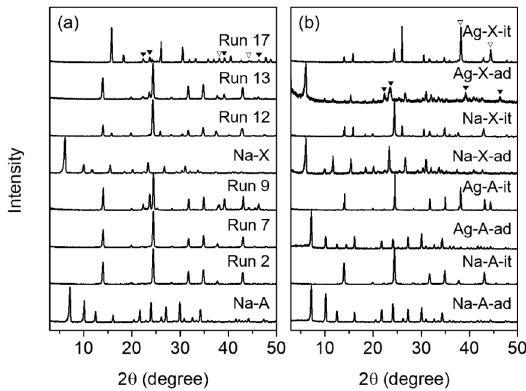
Figure 2. Powder XRD patterns of ( a ) representative products synthesized by the interzeolite transformation of Na-A and Na-X and ( b ) Na-A, Ag-A, Na-X, and Ag-X after the adsorption of CH 3 I and their interzeolite transformation products. For comparison, the XRD patterns of parent Na-A and Na-X are also displayed. The X-ray peaks from AgI and Ag metal are marked by closed ( ▼ ) and open inverted triangle ( ∇ ), respectively.